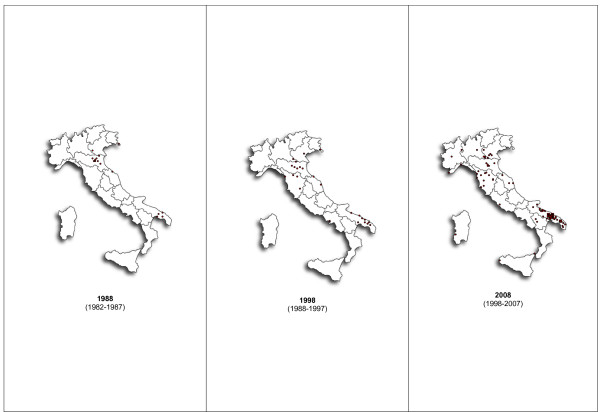
Distribution of OHHs in Italy in the years 1988, 1988, 2008. In 1988 the first ODO-ANT was founded in Taranto, in the south of Italy. Since that time, the number of periphery national offices has progressively increased. At the end of 2008 there were 23 OHHs in Italy.